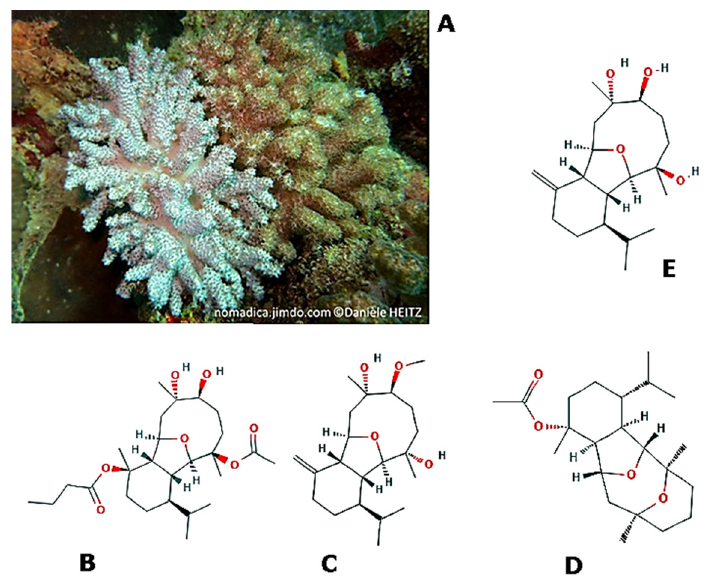
Figure 9. A ) A specimen of Cladiella pachyclados soft coral © Danièle Heitz;